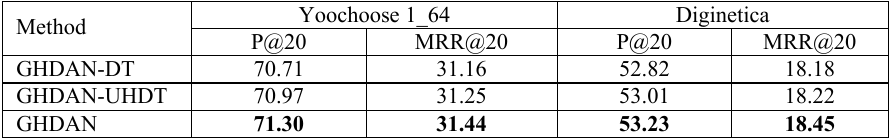
Table 4. Performances of different comparison methods on the two